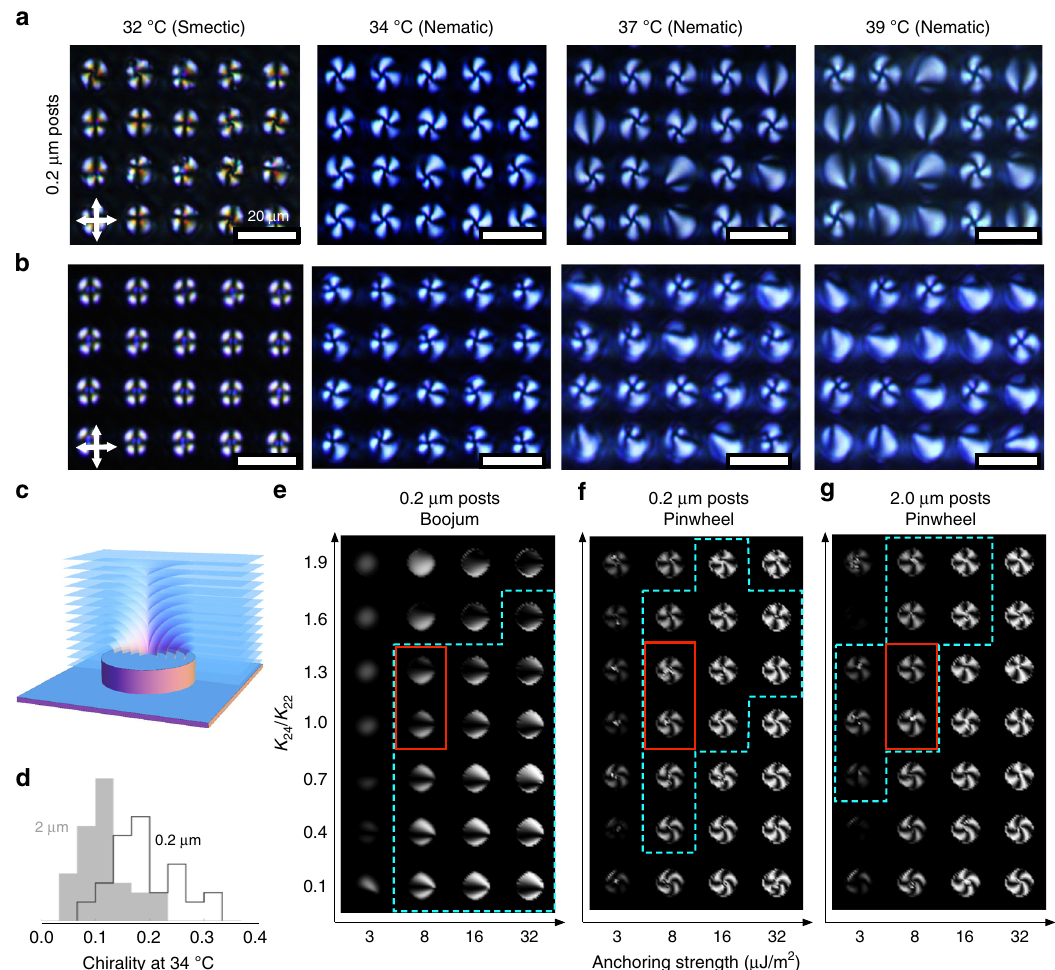
Fig. 3 Spontaneous chiral symmetry breaking for 8CB on circular posts. POM images of 8CB on a 0.2 μ m and b 2.0 μ m posts at various temperatures. Both samples were slowly heated (1 °C/min) from smectic phase to nematic phase. c Schematic of the smectic layers adopted by 8CB on top of a SU8 post, forming a toroidal focal conic domain (TFCD). Within a TFCD, radial in-plane LC director is strongly imposed. d Frequency histograms of quantitative chirality measurements for 8CB at 34 °C in the nematic phase over 40 posts. The magnitude of the chirality is in fl uenced by the post height, such that short posts induce greater chiral symmetry breaking. e – g Simulated POM images of 8CB alignment at 34 °C as a function of saddle-splay constant ( K 24 = K 22 ) and SU8 surface anchoring strength. Blue dash boxes indicate structures consistent with experiment as described in the main text; the intersection of these three regions is highlighted in